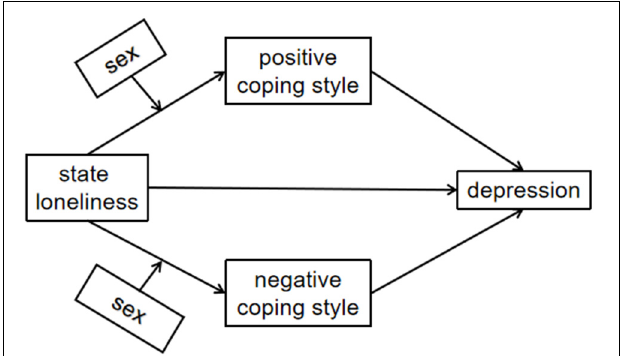
FIGURE 1 | The hypothetical